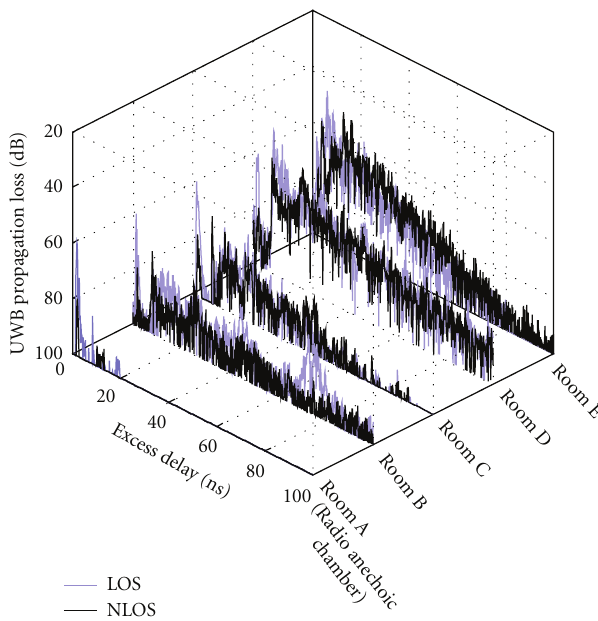
Figure 3: Example of the delay profiles measured in Rooms A to E [5].